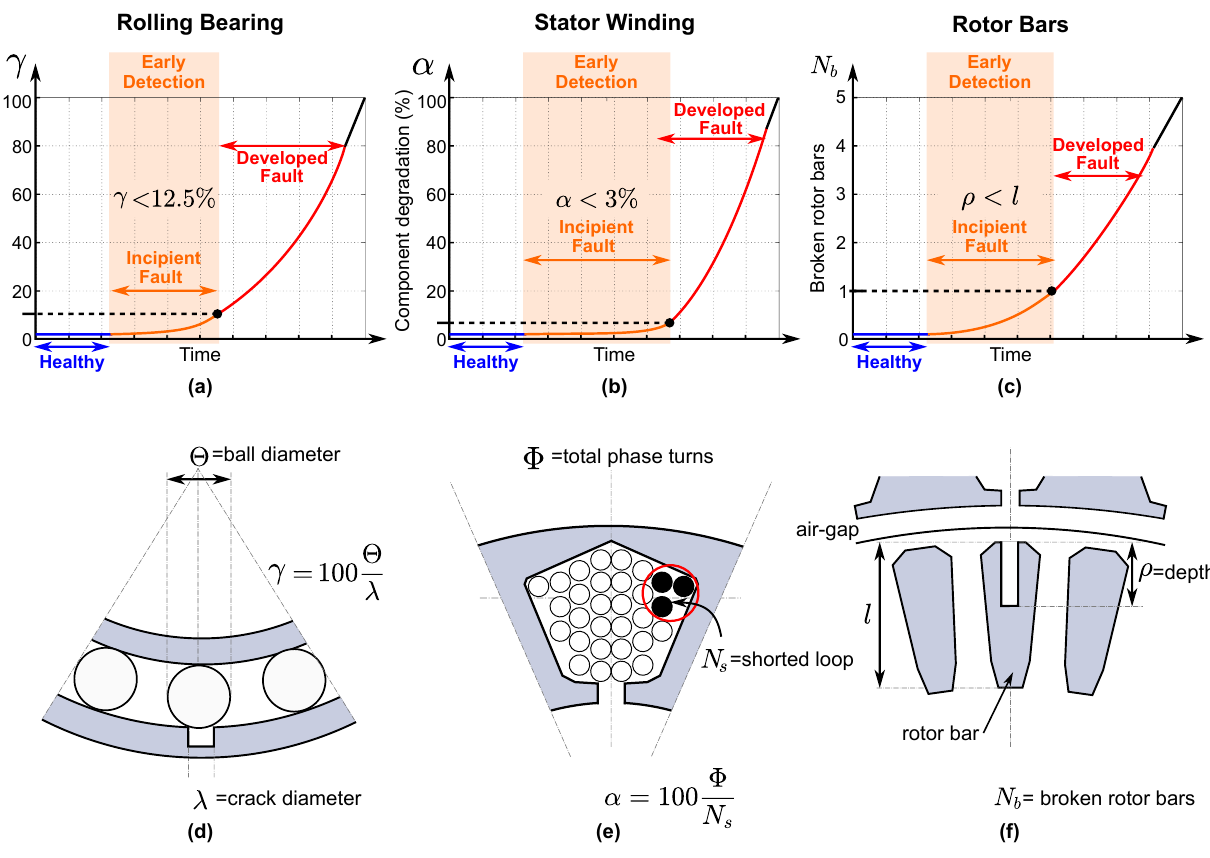
Figure 2. Degradation stages of induction motor components: ( a ) rolling bearing degradation, ( b ) stator winding degradation, ( c ) rotor bar degradation, ( d ) rolling bearing schematic, ( e ) stator winding schematic, and ( f ) rotor bars